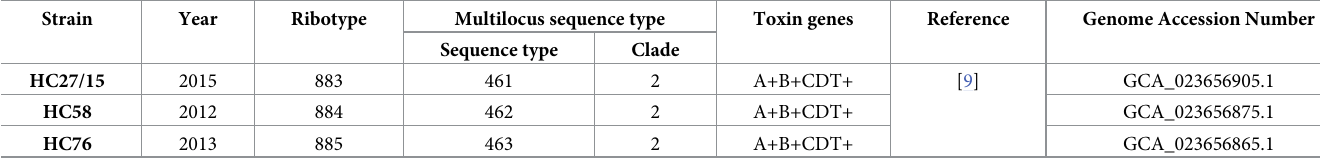
Table 1. Sequence type, ribotyping, year of isolation, and presence of the main toxin genes in the three Brazilian clade 2 strains isolated between 2011 and 2015 in Belo Horizonte, Minas